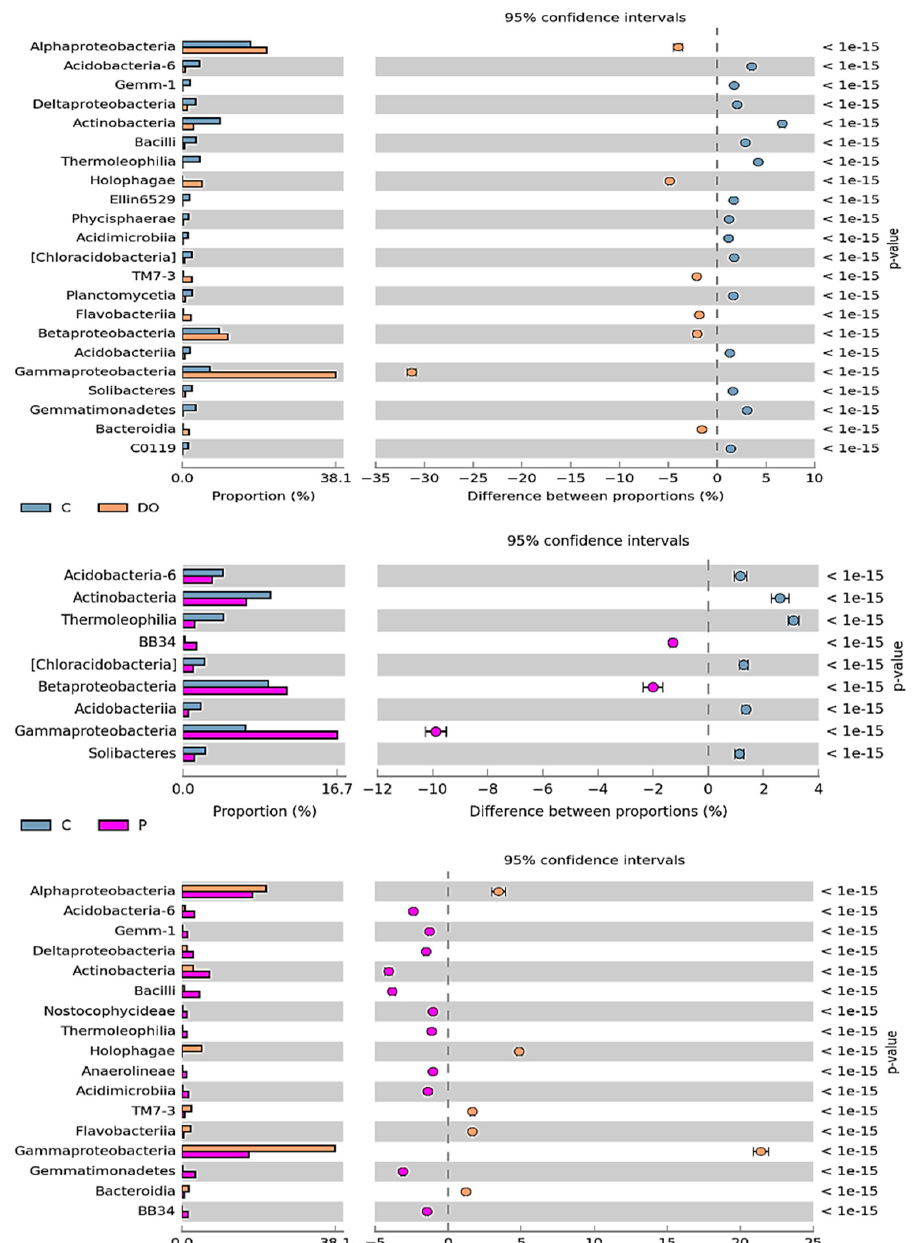
Figure 3. The relative abundance of dominant classes of bacteria in the soil with difference between proportions ≥ 1%. C—uncontaminated soil, DO—soil contaminated with diesel oil, P—soil contaminated with unleaded petroleum.